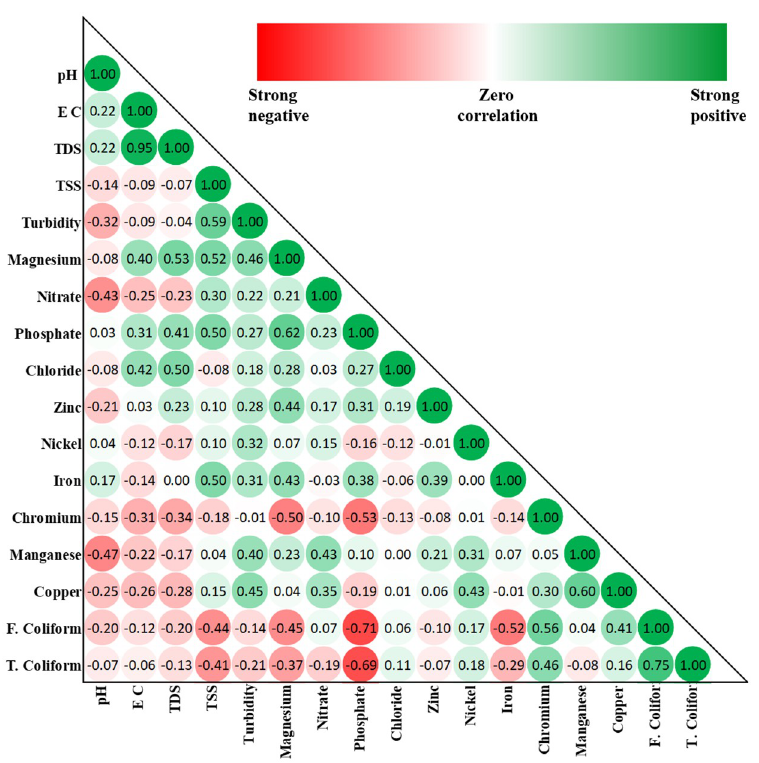
Fig 2. Pearson product moment correlation coefficients of log-transformed ground water